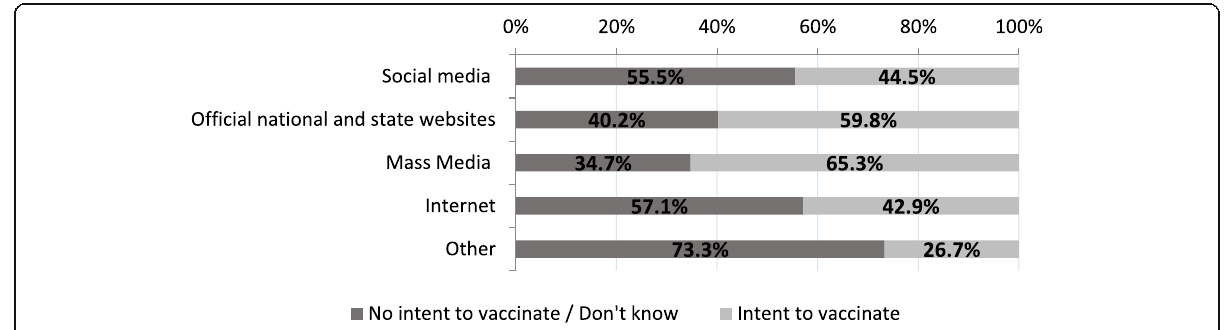
Fig. 1 Association between source of information regarding COVID-19 and willingness of respondents to get vaccinated in